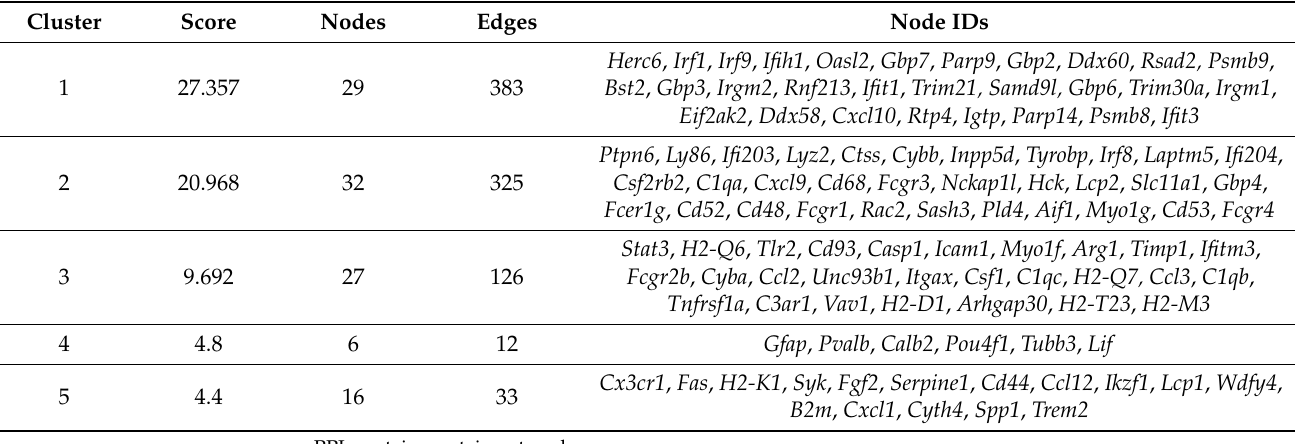
Table 5. Modules screened from the PPI network.